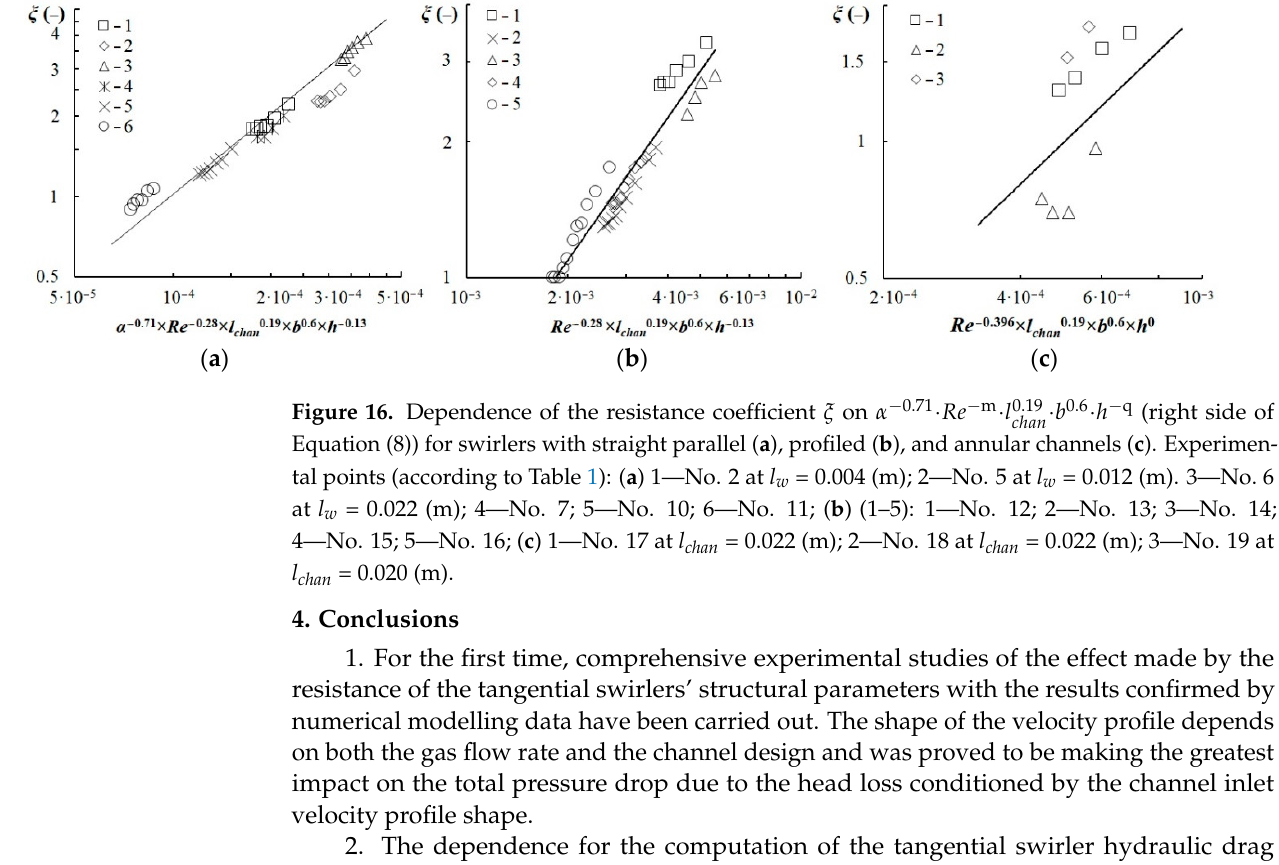
Figure 16. Dependence of the resistance coefficient ξ on 𝛼 (cid:2879)(cid:2868).(cid:2875)(cid:2869) ∙ 𝑅𝑒 (cid:2879)(cid:2923) ∙ 𝑙 (cid:3030)(cid:3035)(cid:3028)(cid:3041)(cid:2868).(cid:2869)(cid:2877) ∙ 𝑏 (cid:2868).(cid:2874) ∙ ℎ (cid:2879)(cid:2927) (right side of Equation (8)) for swirlers with straight parallel ( a ), profiled ( b ), and annular channels ( c ). Ex- perimental points (according to Table 1): ( a ) 1—No. 2 at l w = 0.004 (m); 2—No. 5 at l w = 0.012 (m).